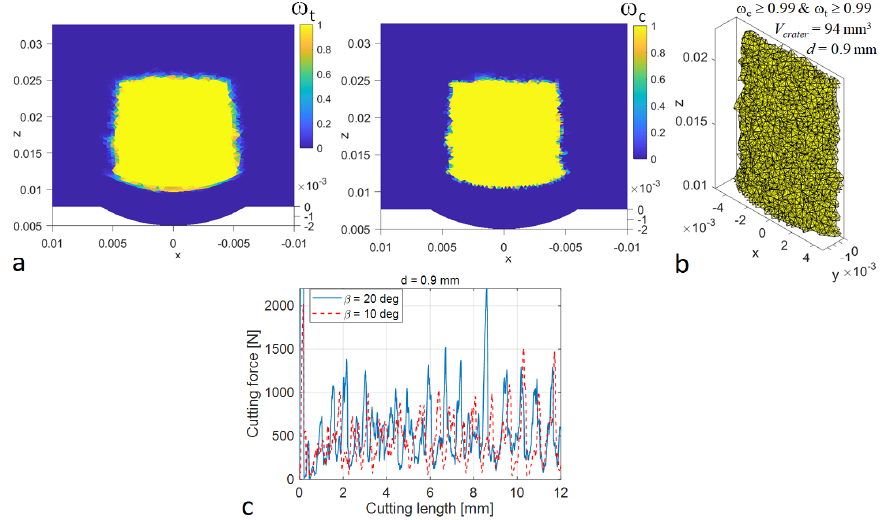
Figure 8. Simulation results for PDC cutting with β = 10 ◦ ( d = 0.9 mm, w c = 0.15): ( a ) tensile and compressive damage fields; ( b ) removed elements; ( c ) cutting force vs. cutting length.